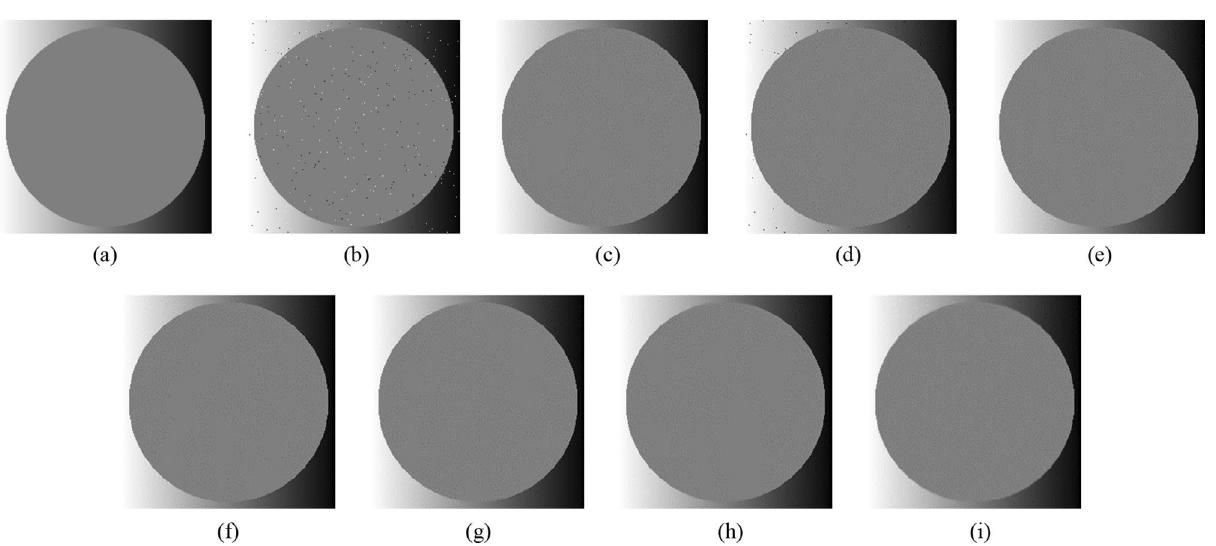
Figure 12. Comparison of denoising performance of each filter against the salt-and-pepper noise (“Geometric pattern”). ( a ) Original image; ( b ) noise-added image; ( c ) filtered image using abwFMGFI; ( d ) filtered image using FMGFI (BW = 1 level); ( e ) filtered image using FMGFI (BW = 3 level); ( f ) filtered image using FMGFI (BW = 5 level); ( g ) filtered image using FMGFI (BW = 11 level); ( h ) filtered image using FMGFI (BW = 21 level); ( i ) filtered image using FMGFI (BW = 51 level).